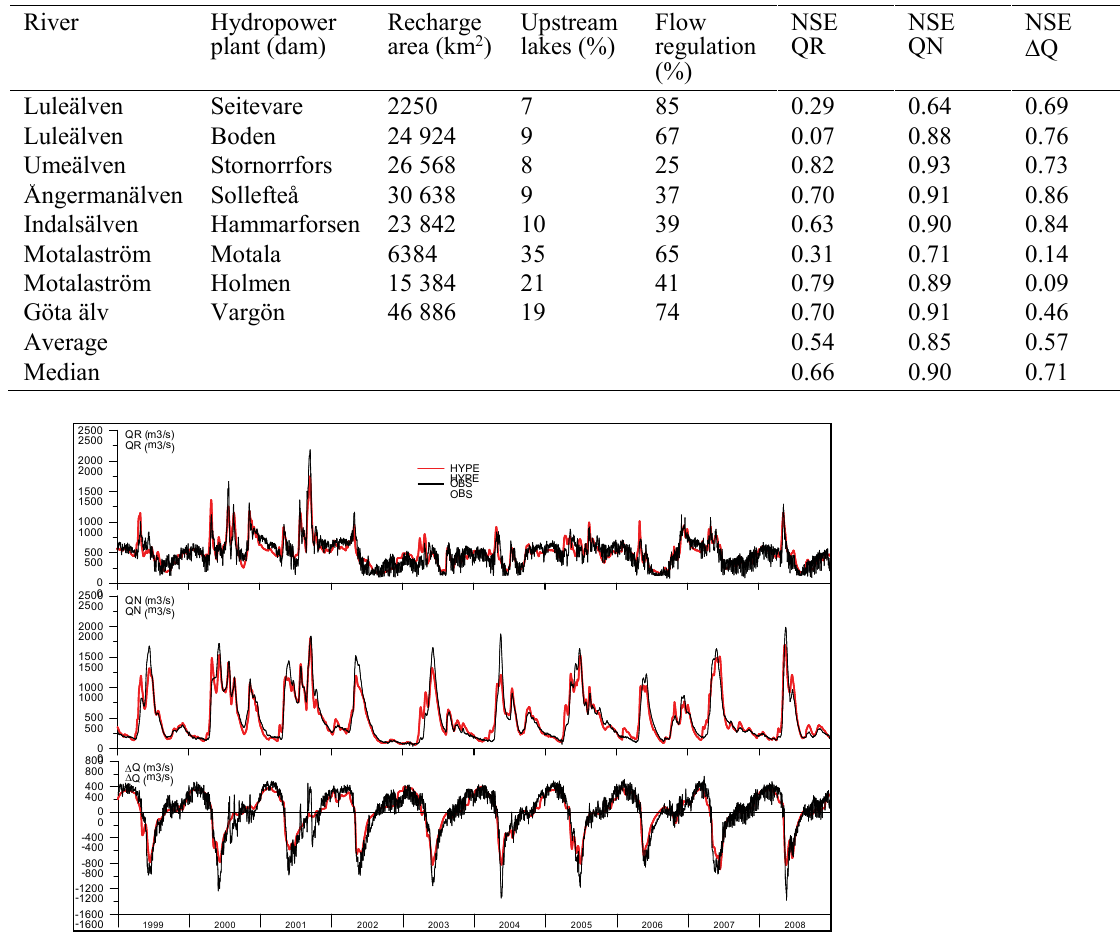
Fig. 3 Time-series of S-HYPE model performance at Sollefteå hydropower plant (D in Fig 1). Top: Simulated and observed water flow including regulation. Middle: simulated naturalized flow and independent reconstruction. Bottom: Simulated impact of hydropower plant on river flow, using S- HYPE and observations combined with independent reconstruction, respectively. observations vs reconstruction, there was normally a good agreement with a median NSE of